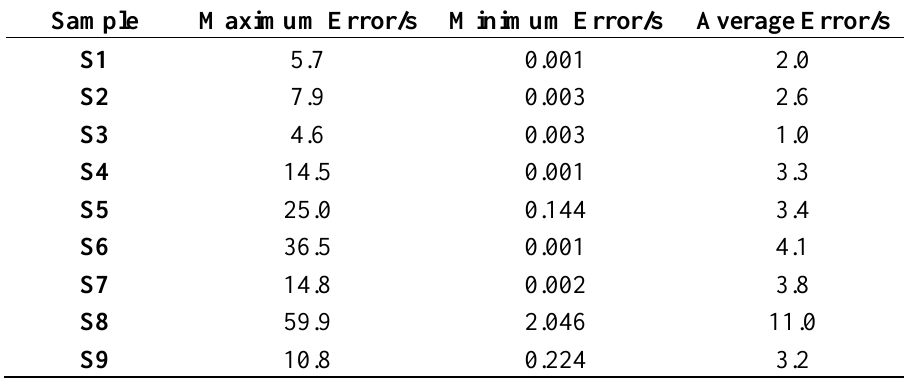
Table 3. Variance between the predicted and actual remaining